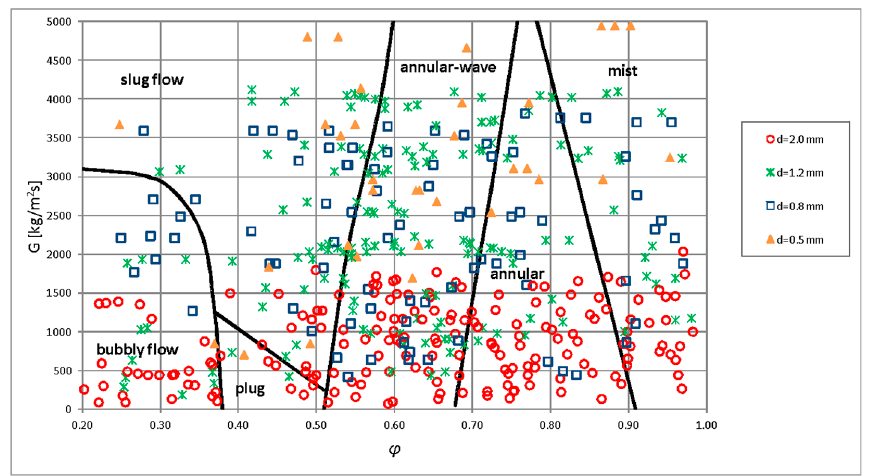
Figure 18. The proposition of a generalized flow structure map during HFE7000, HFE7100, and Novec649 refrigerant condensation in minichannels, taking into account the influence of the internal diameter.